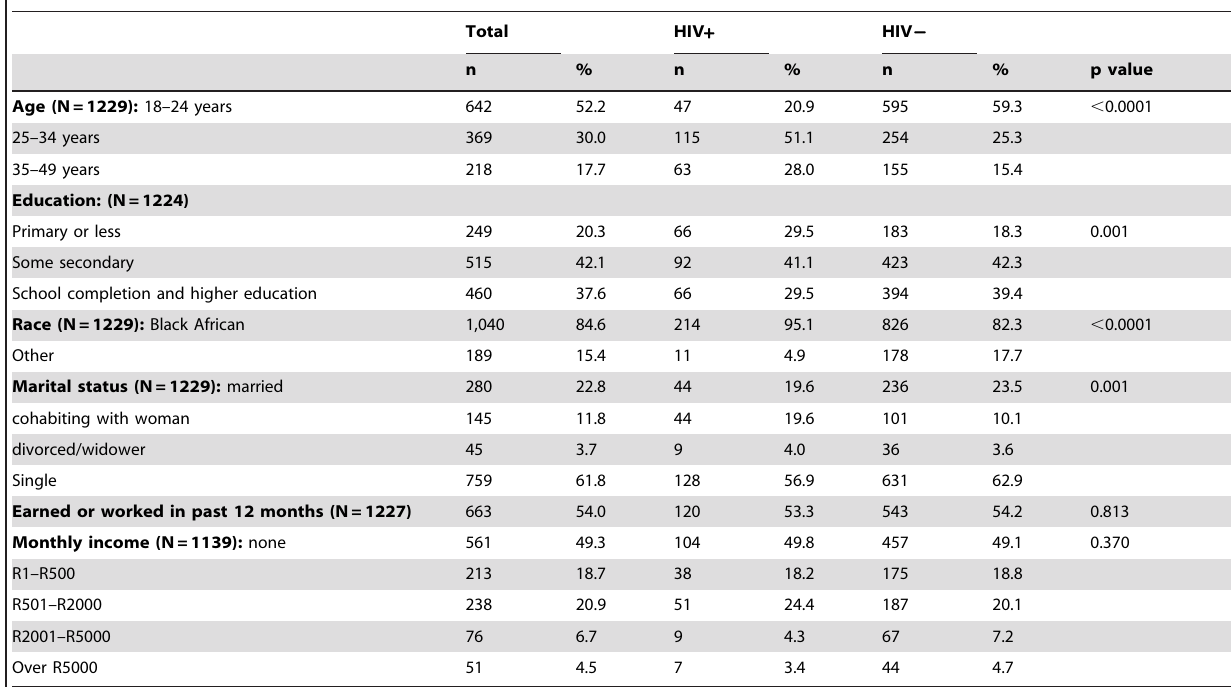
Table 1. Social and demographic characteristics of the sample.